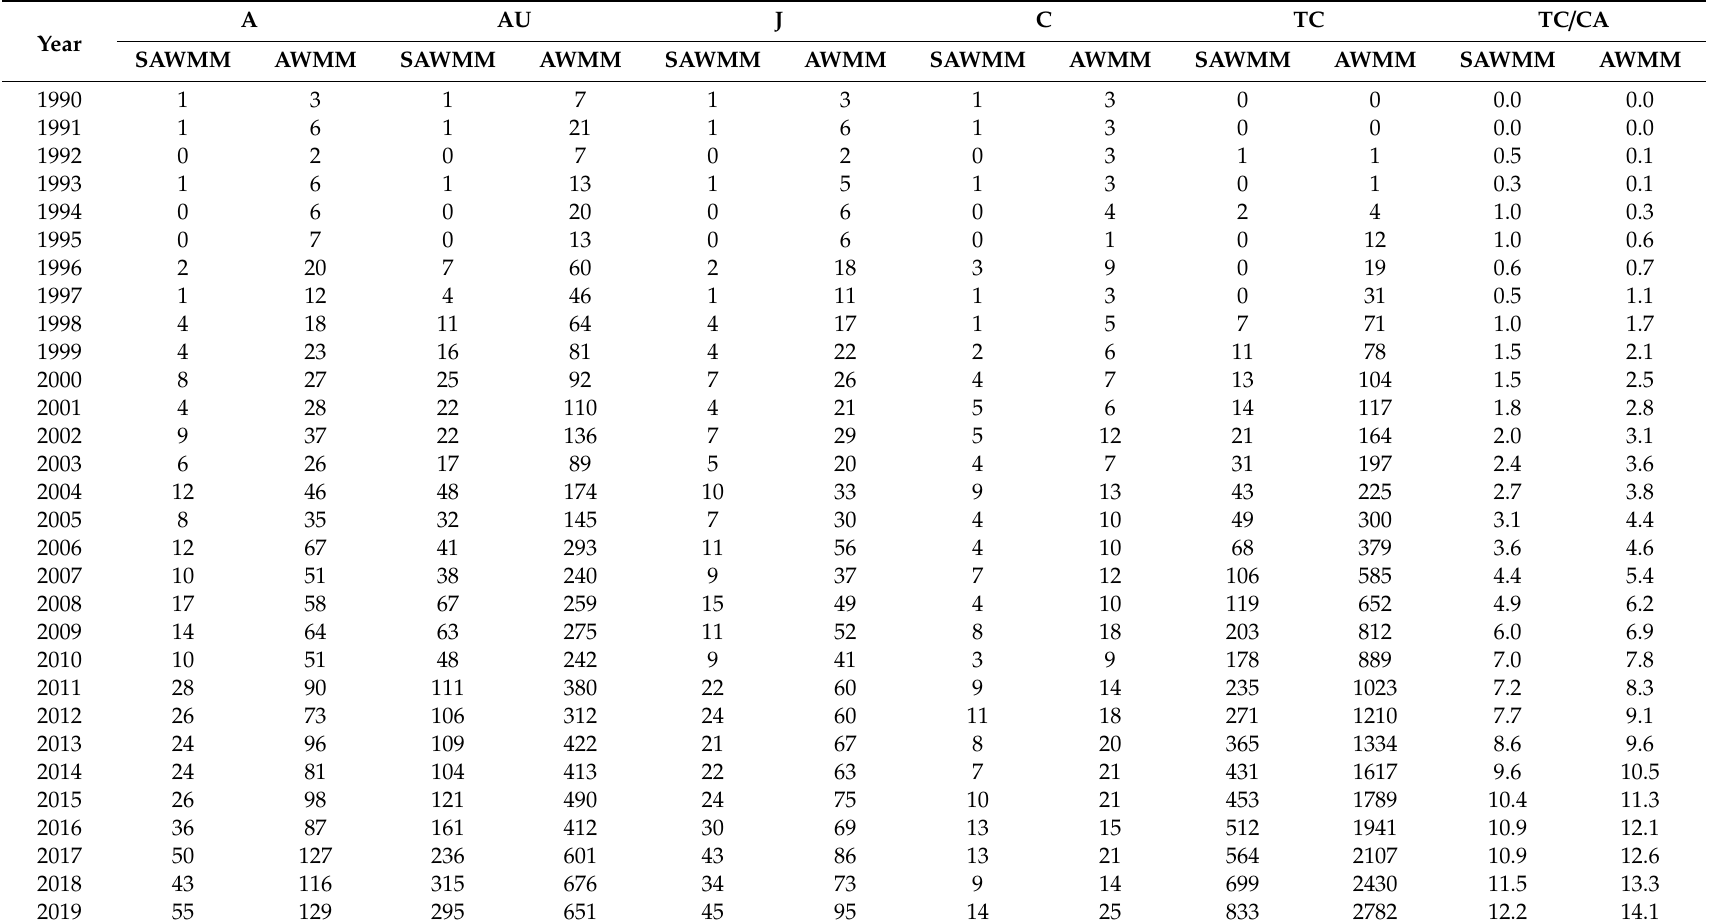
Table 1. Major characteristics of agricultural water management